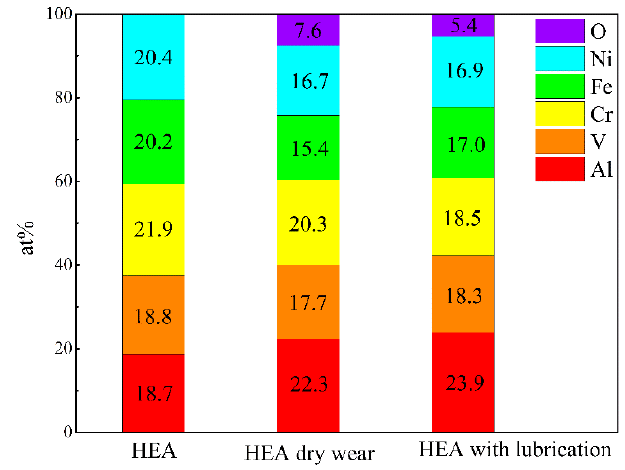
Figure 8. The worn surface SEM image and corresponding EDX mapping of ( a ) HEA dry wear and ( b ) HEA with lubrication.